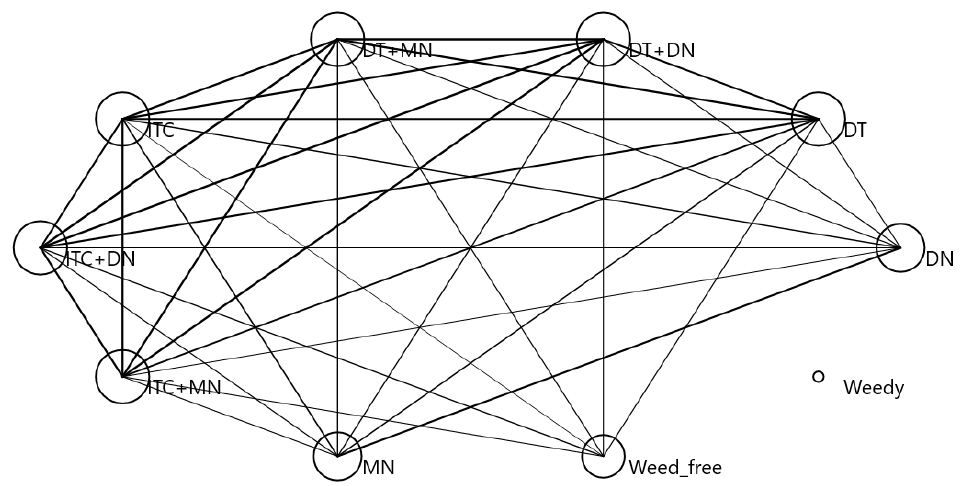
Figure 8. Heat map of the parameters corresponding to the treatments.